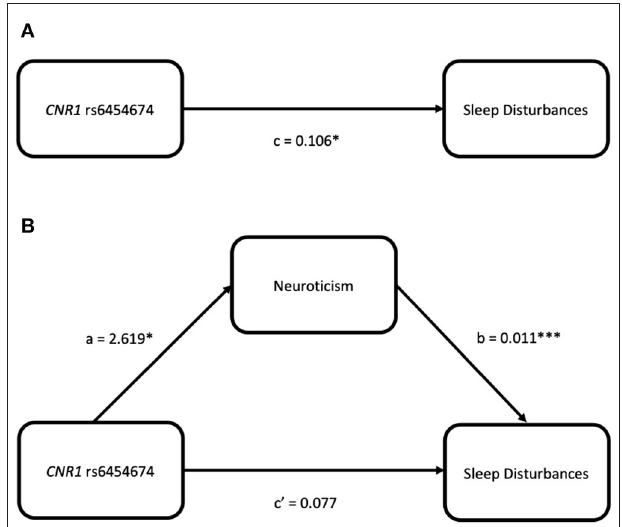
FIGURE 5 | Simple mediation models for CNR1 rs6454674 and sleep disturbances (from the PSQI) via neuroticism (from the NEO-PI-R). (A) Depicts the significant effect of genotype on sleep disturbances. (B) Indicates the significance is dropped when neuroticism is added as a mediator, suggesting neuroticism fully mediates the relation between CNR1 rs6454674 genotype and sleep disturbances.